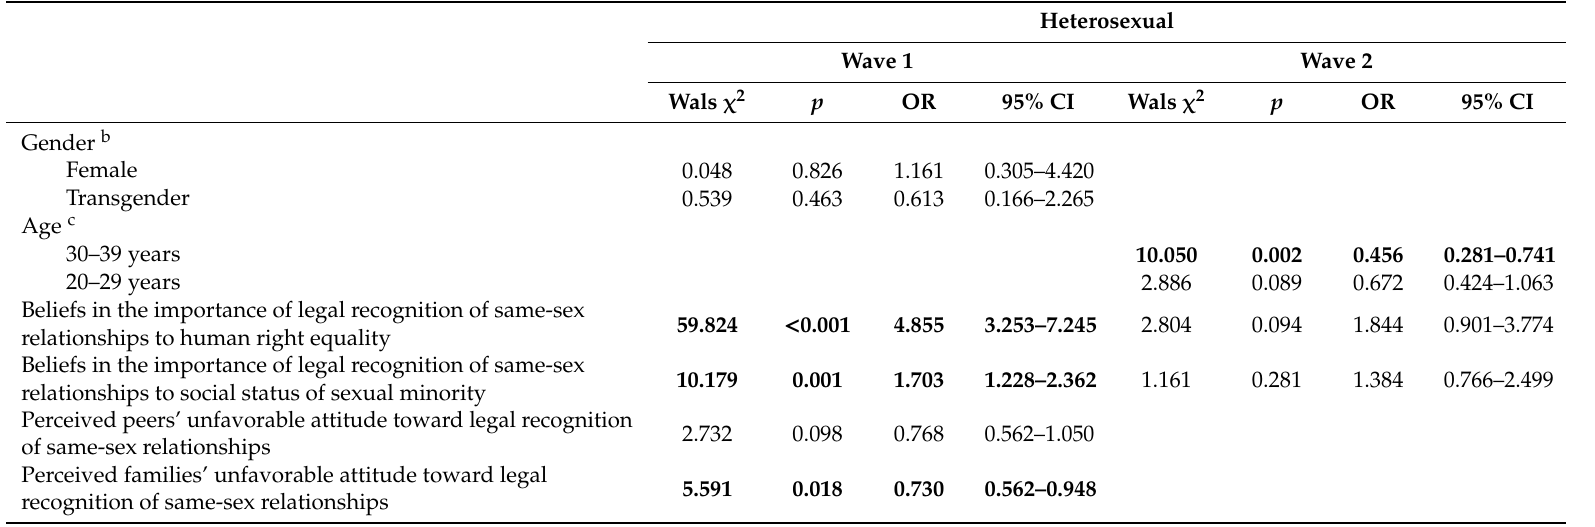
Table 4. Factors related to preference of establishing same-sex marriage law in the Civil Code among heterosexual participants supporting the legalization of same-sex relationships in Wave 1 and Wave 2 a